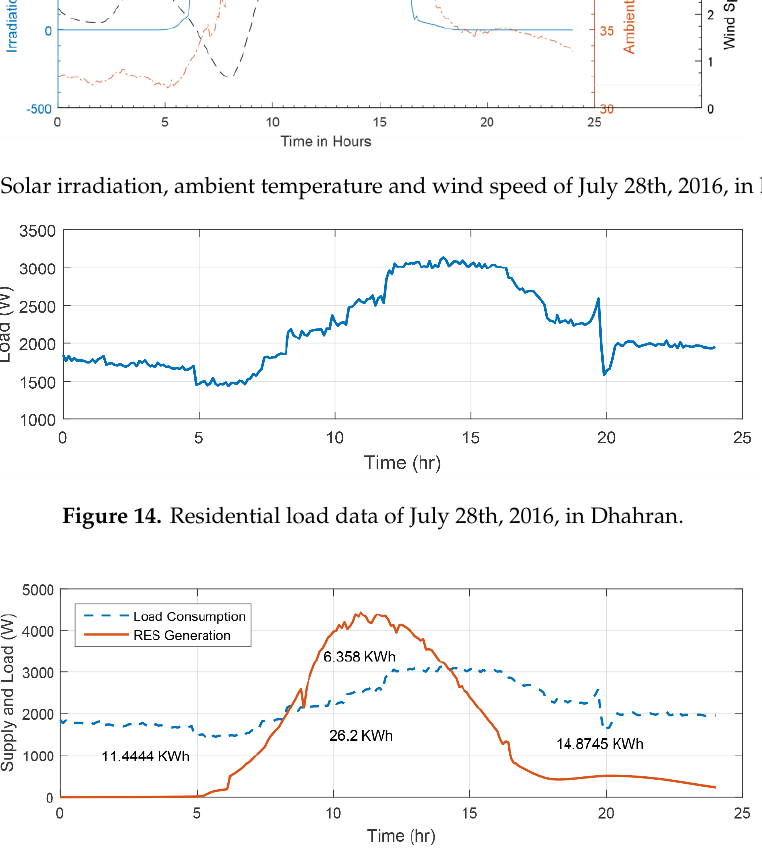
Figure 15. Renewable energy generation (REG) versus load demand energy analysis during the day hours. Table 4. Battery energy storage (BES) energy analysis for 24 h.